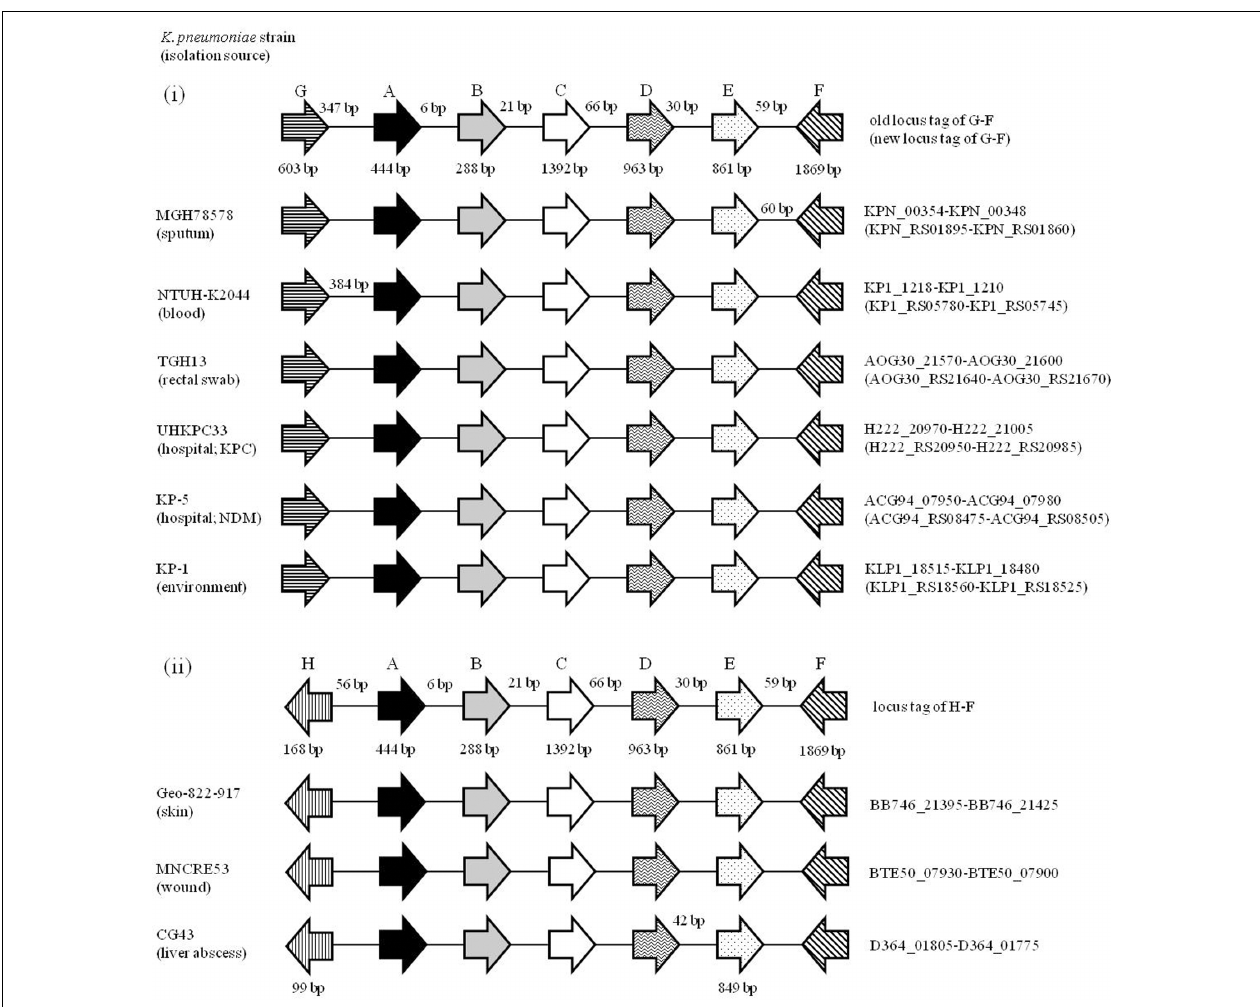
FIGURE 1 | Alignment of the KPN00354-KPN00348 locus in different K. pneumoniae isolates. Open reading frames (ORFs) A, B, C, D, E, F and G are homologues of KPN00353, KPN00352, KPN00351, KPN00350, KPN00349, KPN00348 and KPN00354, respectively. ORF A is an EIIA homologue (black arrow). ORF B is an EIIB homologue (gray arrow). ORF C is an EIIC homologue (white arrow). ORF D is a protein containing the PfkB-specific motif (arrow with wavy line inside). ORF E is a putative type II Fba (arrow with dot inside). ORF F is predicted to encode amidohydrolase (arrow with slash inside). ORF G is predicted to encode peroxiredoxin (arrow with horizontal line). ORF H is a hypothetical protein (arrow with vertical line). Arrows denote the direction of transcription. The gene lengths and the lengths between each ORF are shown in representative graphs but the lengths different from representative graphs are shown on separate